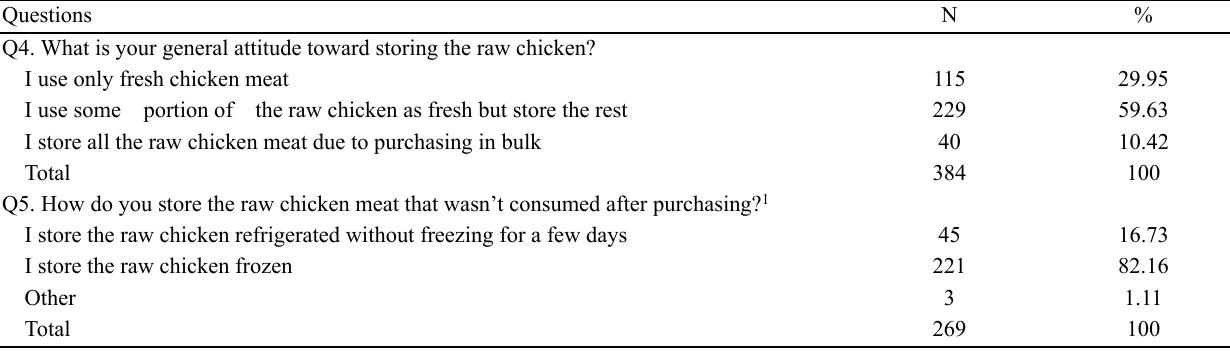
Table 2. Questions related to consumers’ attitudes toward storing the raw chicken Questions